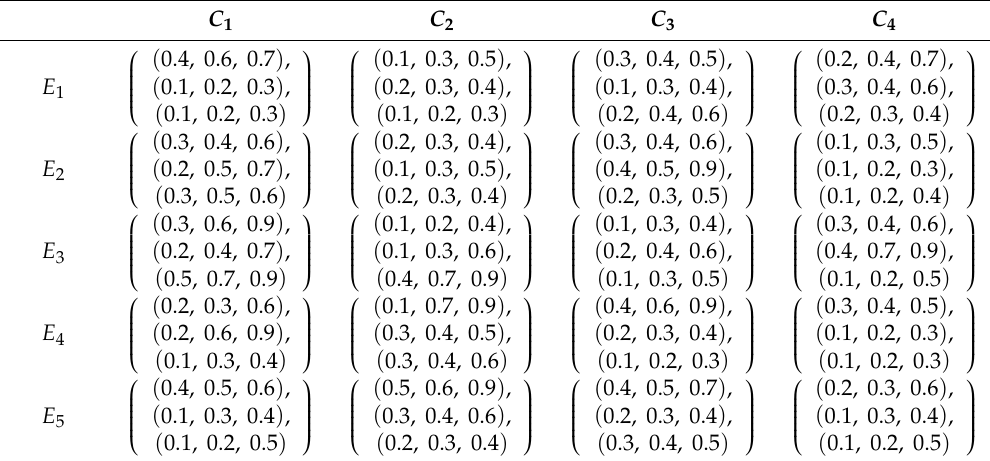
Table 2. TFNNs judgement matrix by the decision maker d 2 .